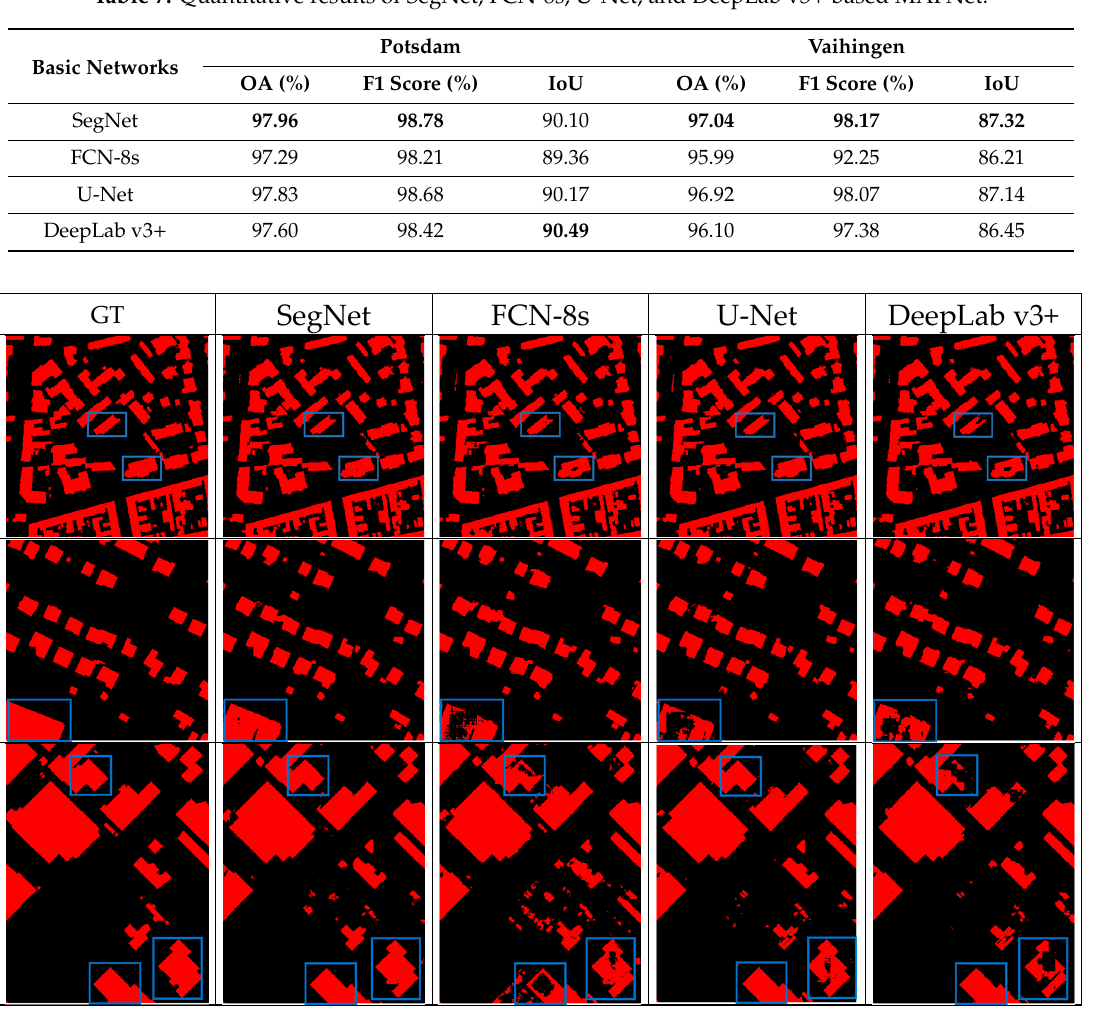
Figure 10. Building extraction results using SegNet, FCN-8s, U-Net, and DeepLab v3+ based MAFNet. Table 7. Quantitative results of SegNet, FCN-8s, U-Net, and DeepLab v3+ based MAFNet.